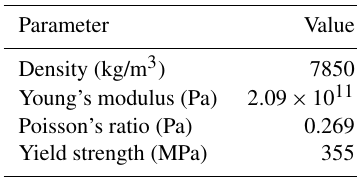
Table 2. Material parameter.